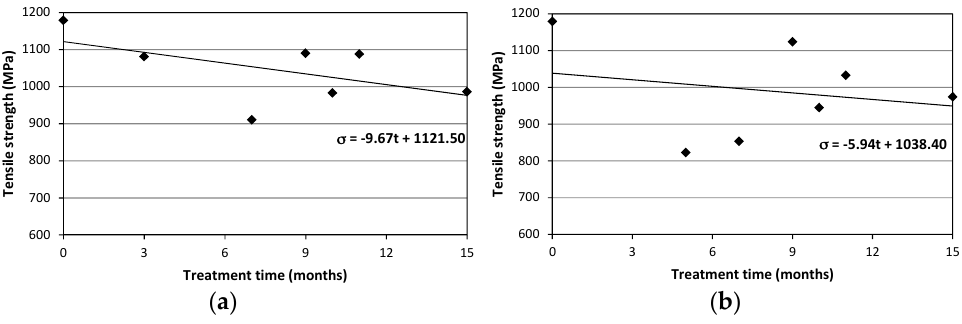
Figure 13. Tensile strength vs. treatment time for SR-series ( a ) NaCl solution; ( b ) deionized water.